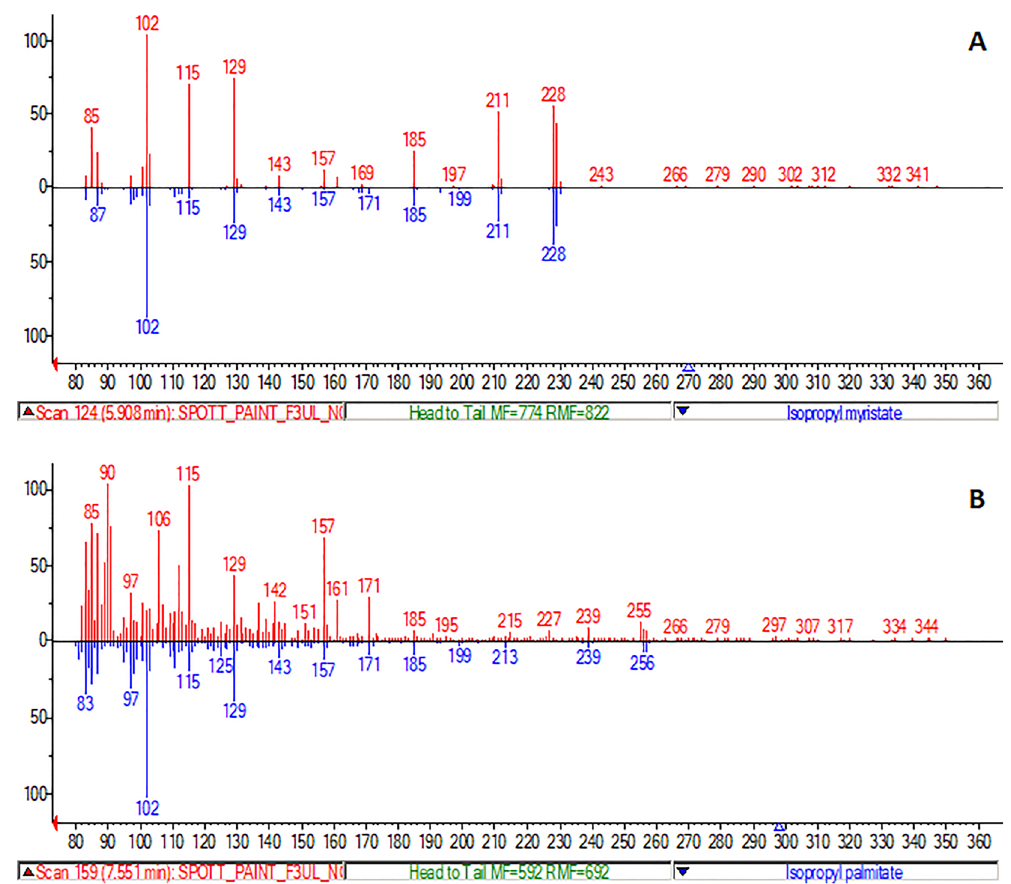
Figure 7. ( A ) Spectrum obtained from the analysis of the painting surface: TIC; ( B ) spectrum obtained from the analysis of the painting deeper layer: TIC. NIST library spectra matching: red, experimental spectra for isopropyl myristate ( C ) and isopropyl palmitate ( D ); blue, library